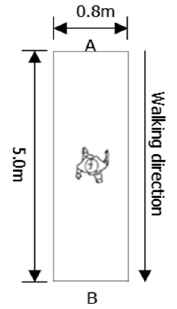
Figure 8. Data collection environment (top down view).